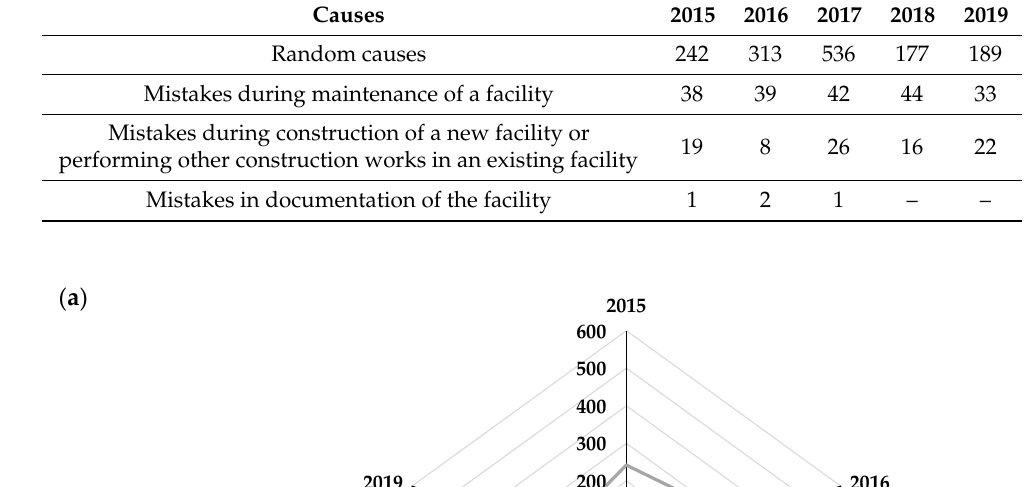
Table 1. Structure of the causes of structural failures in the period 2015–2019 in Poland (own study).